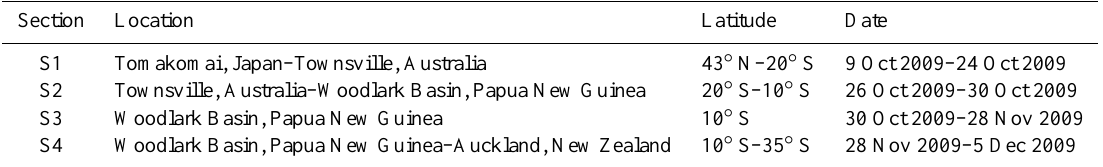
Table 1. Description of the four sections (S1–S4) of the ship campaign with RV Sonne according to Fig. 1. Section S1 is further described in Kr¨uger and Quack (2012).